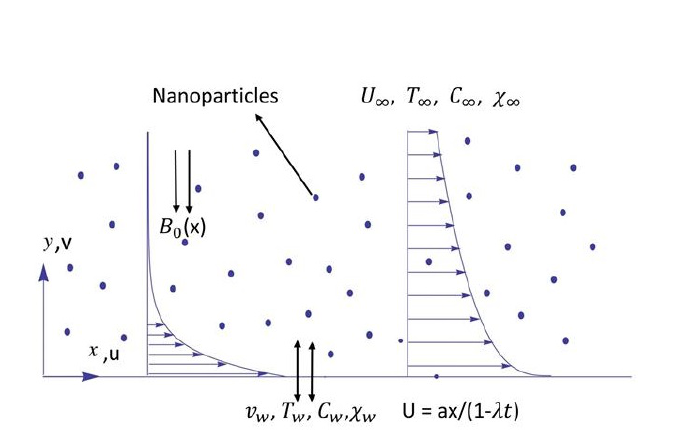
Figure 1. Physical configuration and coordinate